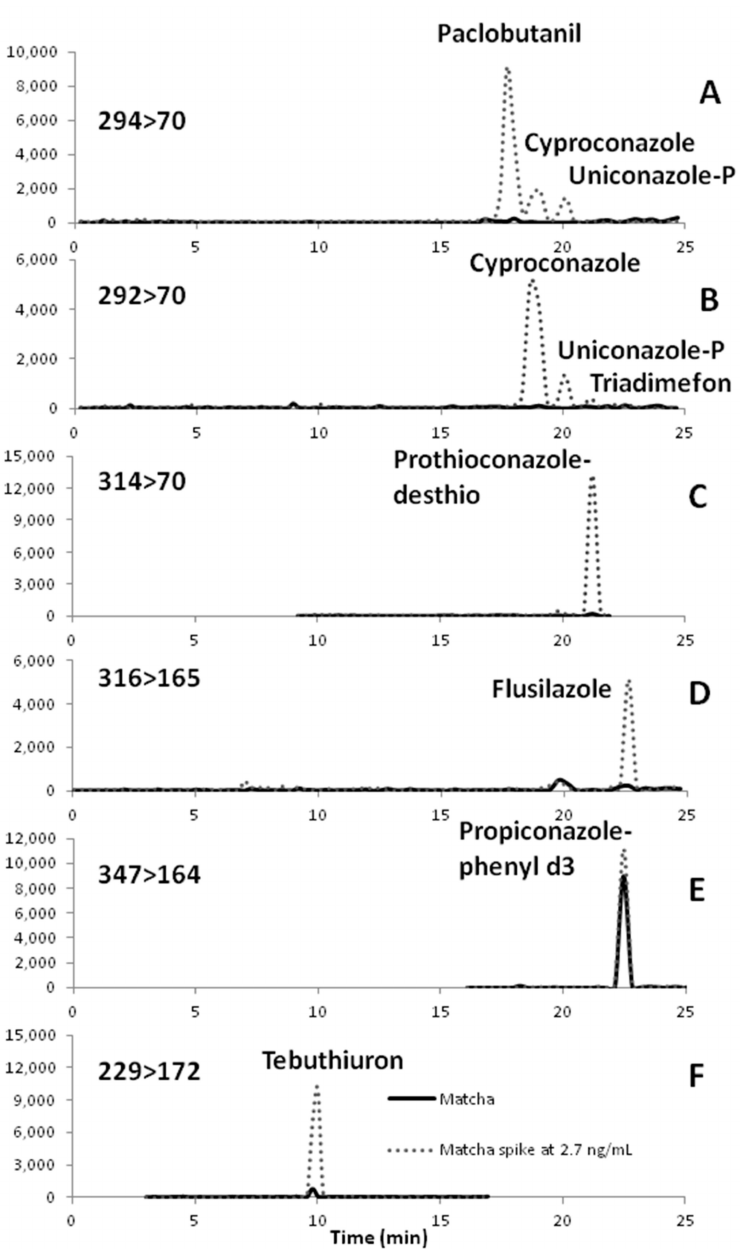
Figure 2. Selected Reaction Monitoring (SRM) Chromatograms of Matcha and Matcha Spiked with Standard Solution. Sample size of 1 g of Matcha with pre-concentrated of pressurized solvent extraction extract to a volume of 1 mL with extract diluted by factor of 0.43 with methanol. Sample extract is spiked at level of 2.67 ng/mL of standard mixture of conazole fungicides and structurally similar pesticides. Internal standard (propiconazole-phenyld 3 ) added to sample at concentration of 50 ng/mL. SRM Chromatograms: A, SRM 294>70; B, SRM 292>70; C, SRM 314>70; D, SRM 316>165; E, SRM 347>164; F, SRM 229>72. See Table 1 for retention times of